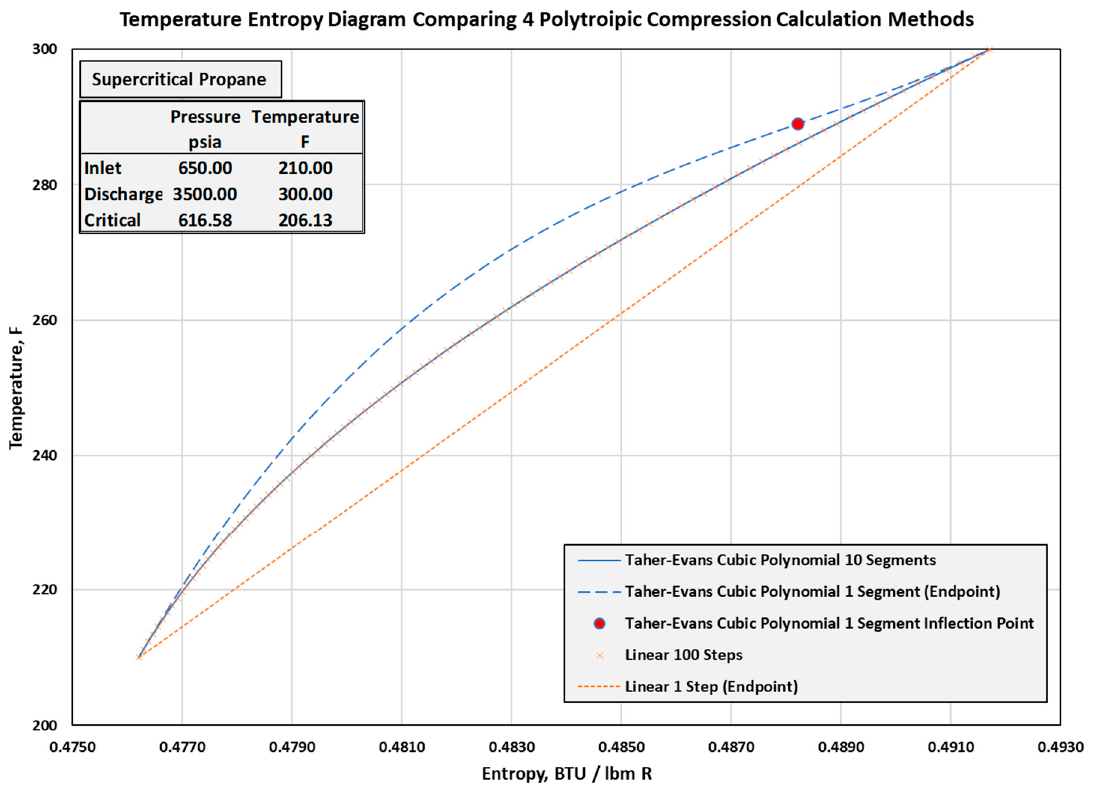
Figure A7. Linear and cubic polytropic compression methods comparisons for supercritical